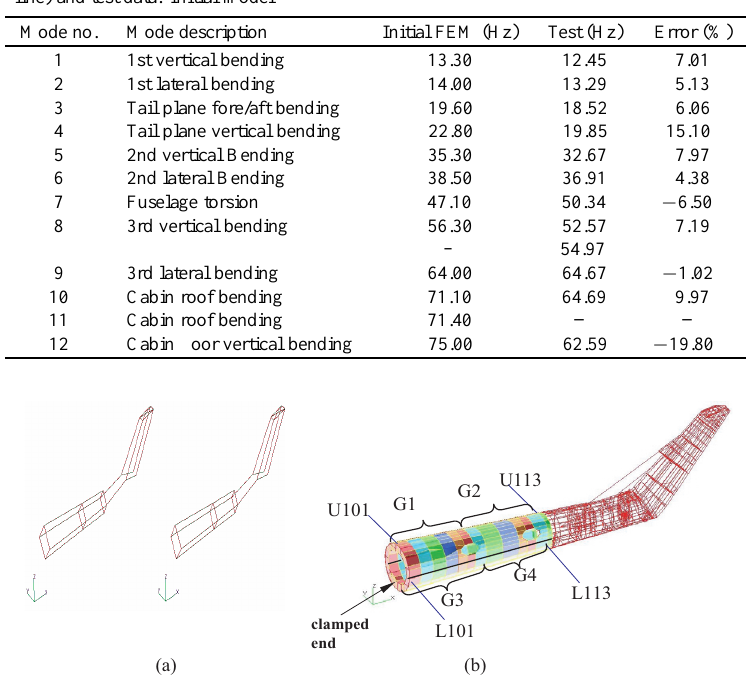
Table 2 Predicted natural frequencies (Hz) and errors (%) between the finite element model